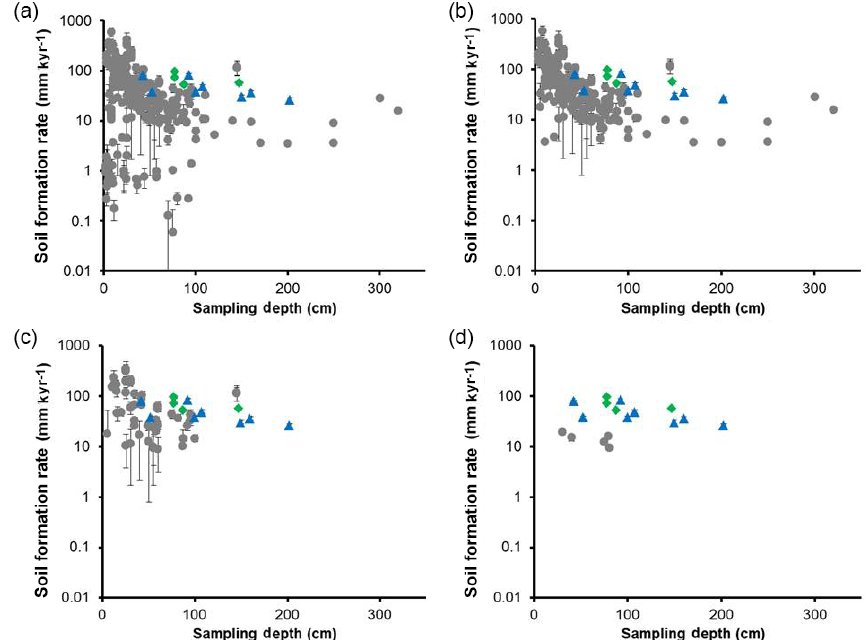
Figure 4. Soil formation rates from a globally compiled inventory (grey circles) and from this study at Rufford Forest Farm (blue triangles) and Comer Wood (green diamonds) plotted against sampling depth. The depth here refers to that for the midpoint (between the top and bottom) of the sample. Rates in grey are from (a) the total mantled inventory ( n = 252); (b) studies from temperate climates ( n = 187); (c) studies on sandstone geology ( n = 57); and (d) the UK, exclusively from Riggins et al. (2011) ( n = 5). Error bars indicate the standard